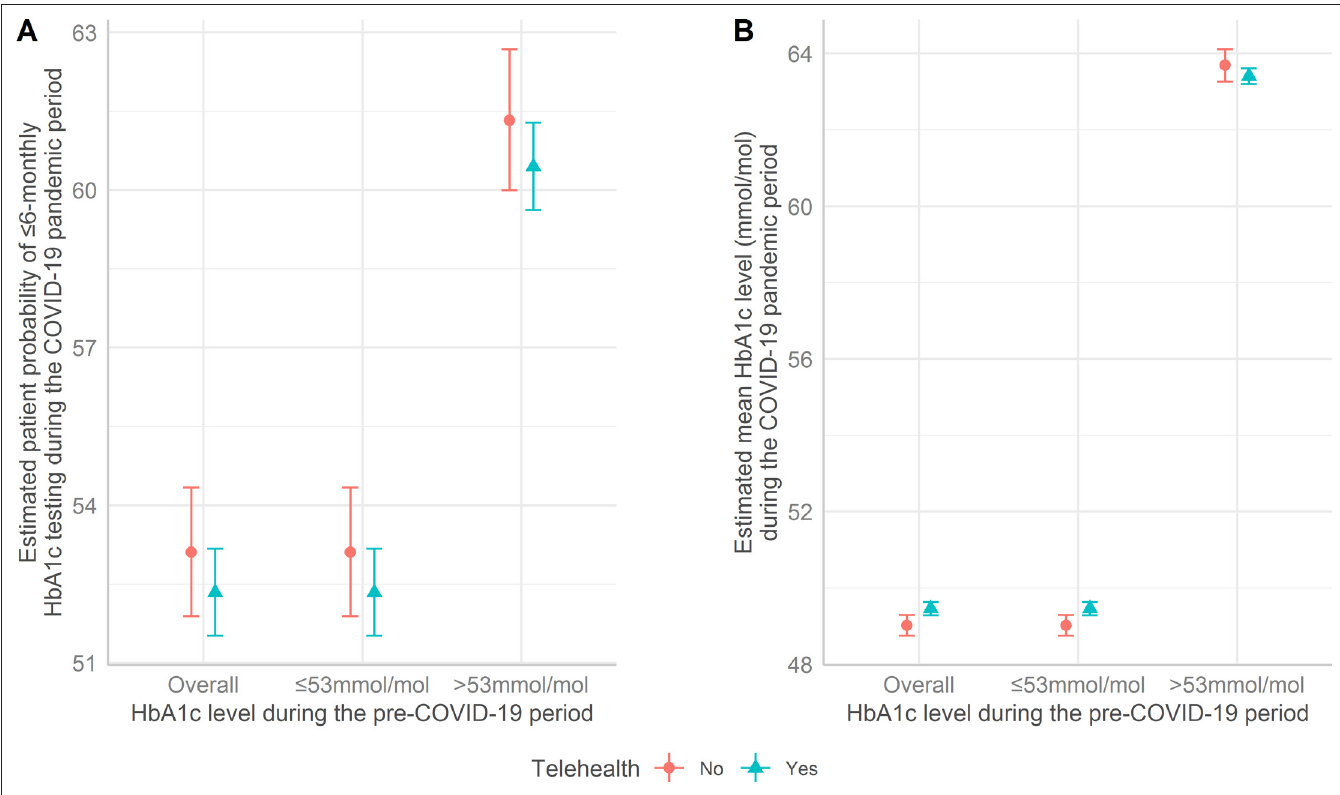
Figure 2 (A) Estimated testing probability for patients to carry out ≤6- monthly HbA1c tests and (B) estimated HbA1c level during the COVID- 19 pandemic